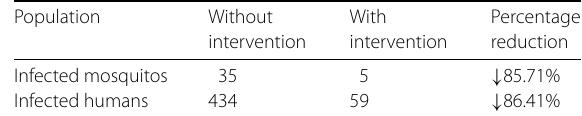
Table 7 The number of each population of infected individuals on the 500th day of the endemic prevention scenario Population Without